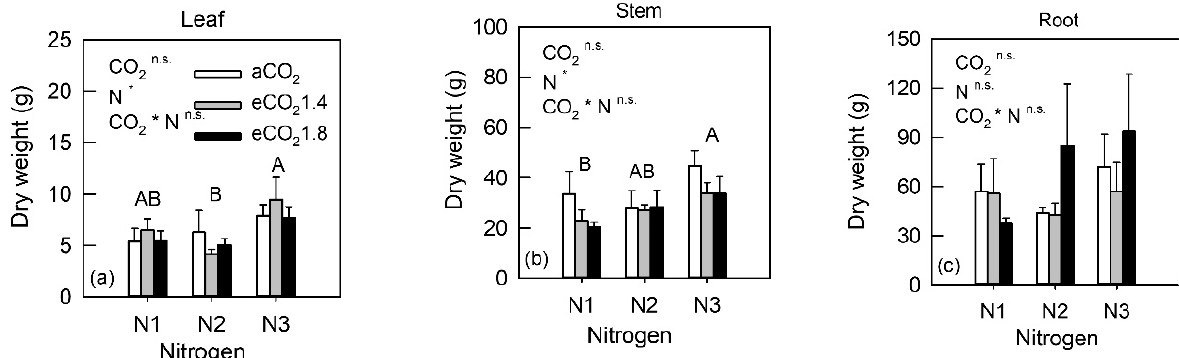
Figure 1. Average dry weight of the ( a ) leaf, ( b ) stem and ( c ) root measured in Fraxinus rhynchophylla grown at three different CO 2 chambers (ambient: aCO 2 ; ambient × 1.4: eCO 2 1.4; ambient × 1.8: eCO 2 1.8) and three different N treatments (N1: unfertilized, N2: N1 + 5.6 gN m − 2 yr − 1 and N3: N1 + 11.2 gN m − 2 yr − 1 ). Results are presented as mean + SE and summary of a two-way ANOVA. In summary of a two-way ANOVA, CO 2 represents CO 2 treatment and N represents nitrogen treatment. The X axis represents N fertilization and CO 2 treatments: aCO 2 (white bar), eCO 2 1.4 (grey bar) and eCO 2 1.8 (black bar). The significance of the primary effects and their interactions are shown with the abbreviations. n.s., non-significant; *, p < 0.05 (two-way ANOVA, CO 2 × N). There were differences between N treatments in dry weight of leaf and stem. Different capital letters indicate significant differences among N treatment and lowercase letters indicate significant differences among CO 2 treatments (Tukey’s test, p < 0.05).